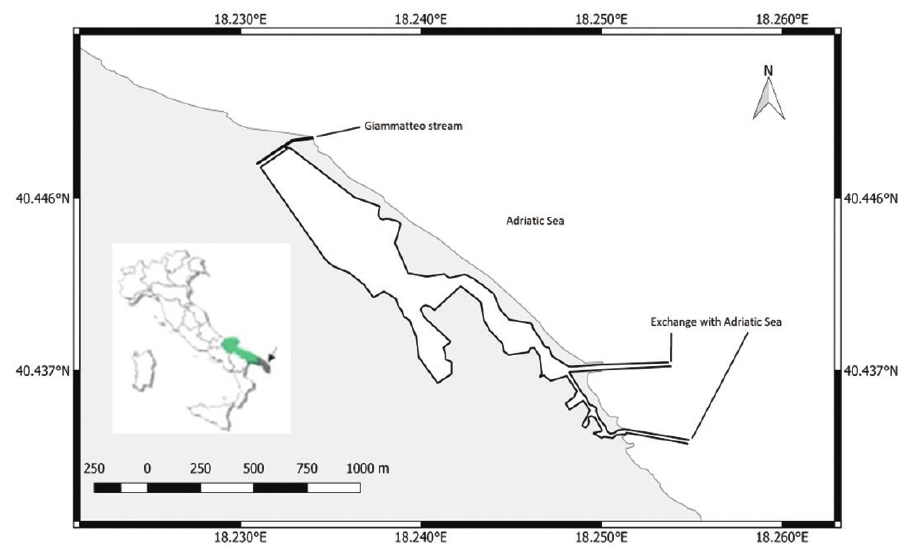
Figure 1. Location and map of Aquatina Lagoon (South-East Italian coastline). The lagoon is included in the NATURA 2000 site “ Aquatina di Frigole ” -